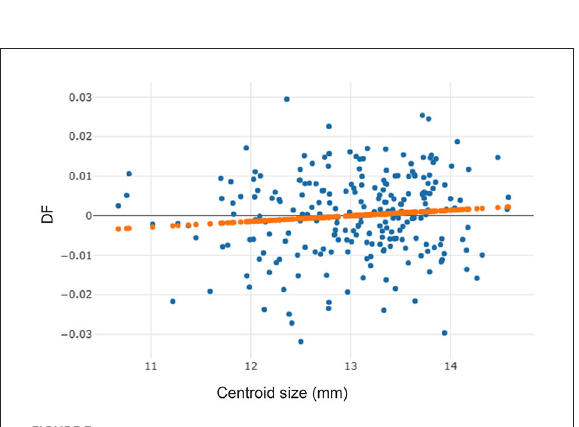
FIGURE3 Linear regression prediction (orange dots line) between wing centroid size (horizontal axis) and discriminant factor (DF) (vertical axis) of Tabanus rubidus specimens.